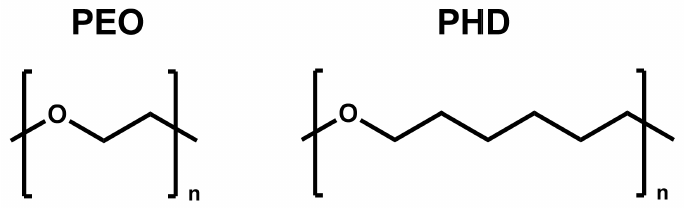
Scheme 1. Chemical structure of the aliphatic polyethers used in this